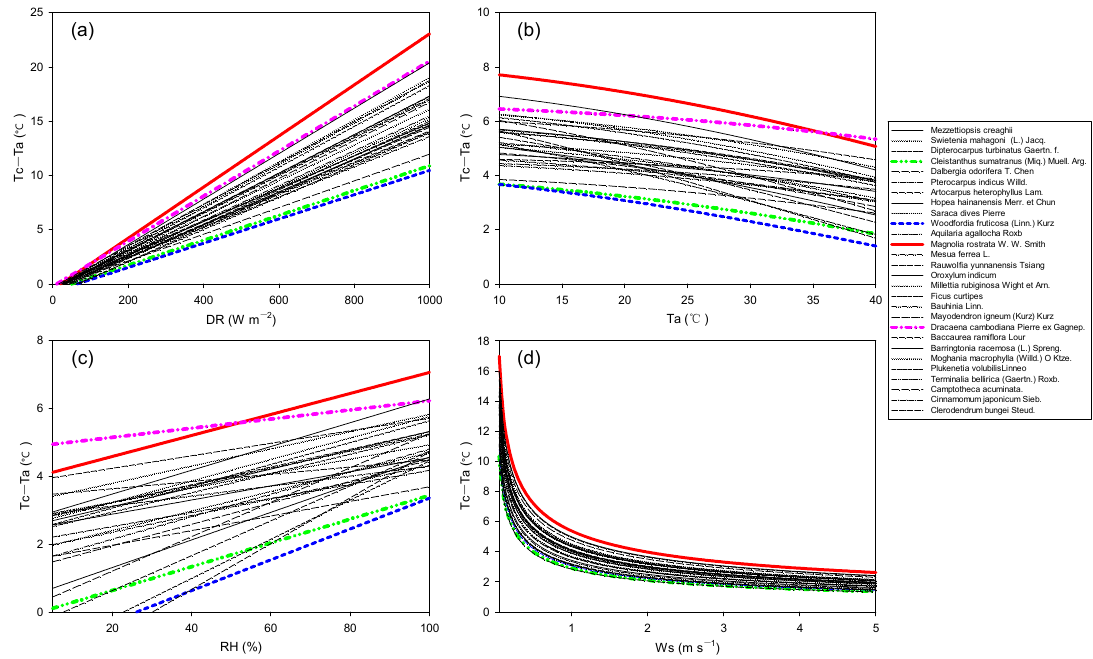
Figure 5. Response of canopy temperature difference (Tc–Ta) to climatic factors, including direct radiation (DR) ( a ), air temperature (Ta) ( b ), relative humidity (RH) ( c ), and wind speed (Ws) ( d ). Red line: Magnolia rostrata W. W. Smith ; pink line: Dracaena cambodiana Pierre ex Gagnep ; blue line: Woodfordia fruticose (Linn.) Kurz ; green line: Cleistanthus sumatranus (Miq.) Muell. Arg . With the increase in direct radiation (DR), the canopy temperature di ff erence (CTD) of large-leaved trees increased more than that of small-leaved trees (Figure 5a). Species-specific di ff erences in (T c –T a ) became larger with the increasing